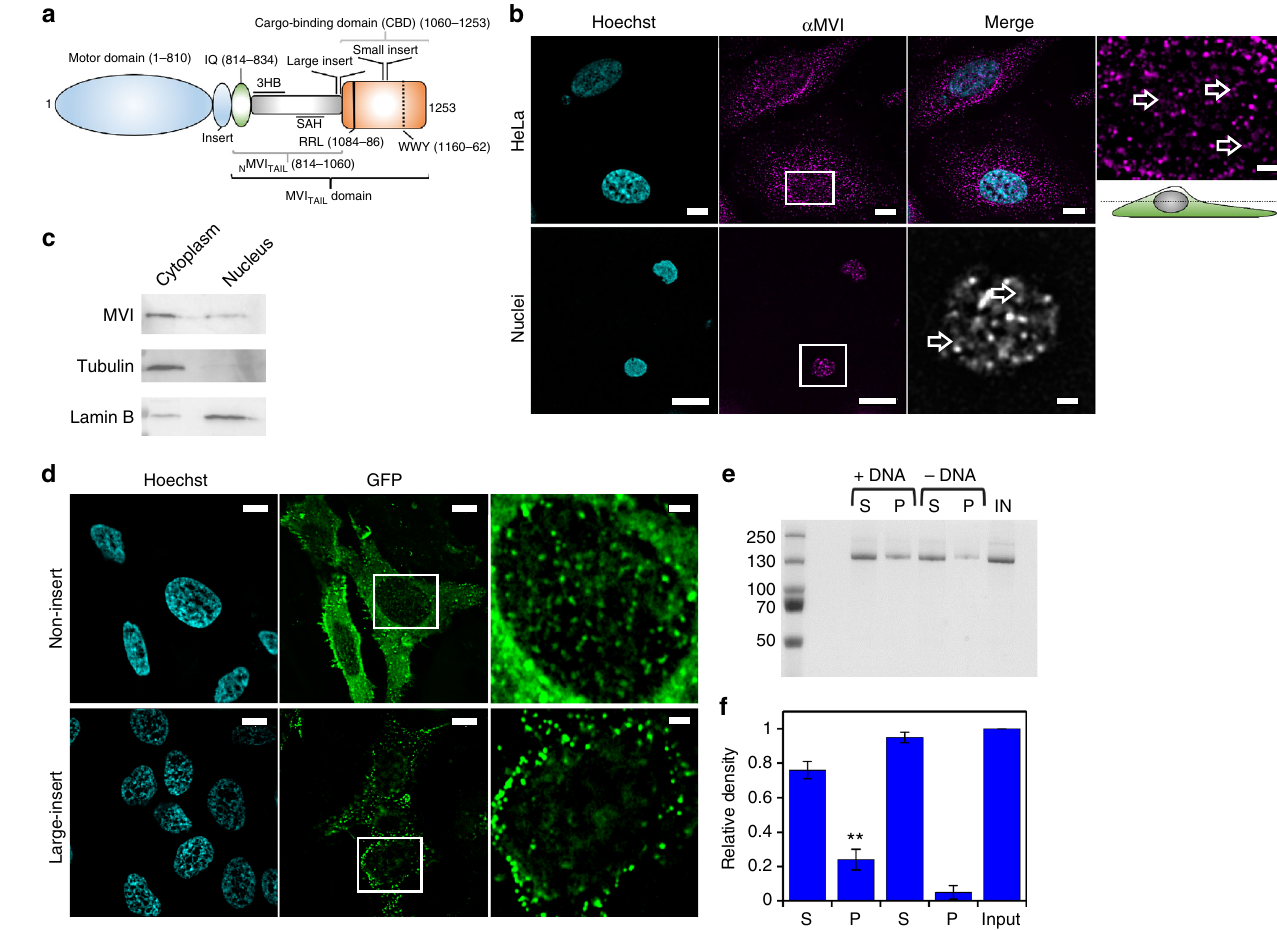
Fig. 1 Myosin VI is distributed throughout the nucleus. a Cartoon depiction of the MVI domains and key features discussed in the text. b Immuno fl uorescence staining against MVI (magenta) and DNA (cyan) in HeLa cells and isolated nuclei (see Supplementary Fig. 1 for nuclei images). Arrows highlight fi lamentous structures within the nucleus. Images were acquired at the mid-point of the nucleus. Scale bar 10 μ m for whole images and 1 μ m for inserts. c Western blot against MVI following HeLa cell fractionation. Tubulin and lamin B are used as cytoplasmic and nuclear markers, respectively. d Representative images of transiently expressed NI- and LI-GFP-MVI in HeLa cells combined with DNA staining (cyan) (Supplementary Fig. 3). Images acquired as in B. e Pull-down of recombinant MVI using a 500 bp DNA substrate. f Plot of band intensities normalised to the input sample (5 μ M). Errors bars represent SEM from three independent preparations. (** p < 0.001 by two-tailed t -test between presence and absence of